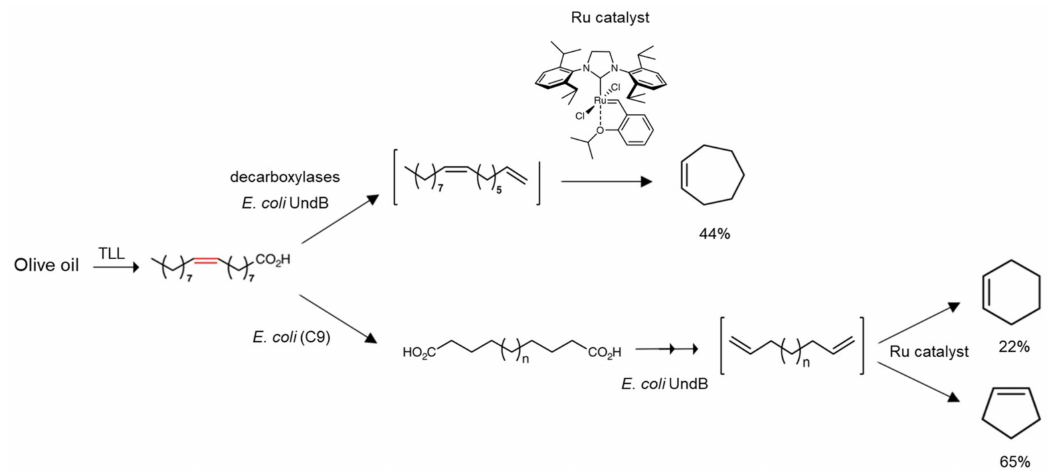
Figure 9. Chemo-enzymatic cascades to produce cycloalkenes from olive oil.